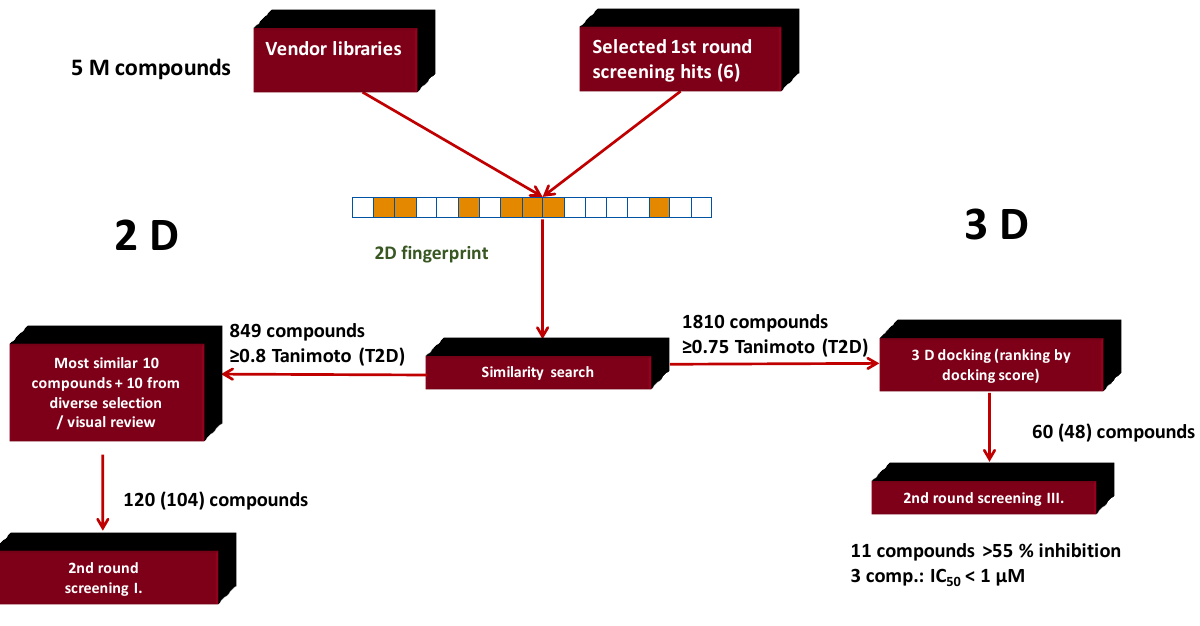
Figure 10. Parallel integration workflow for identification of PDE5 inhibitors.